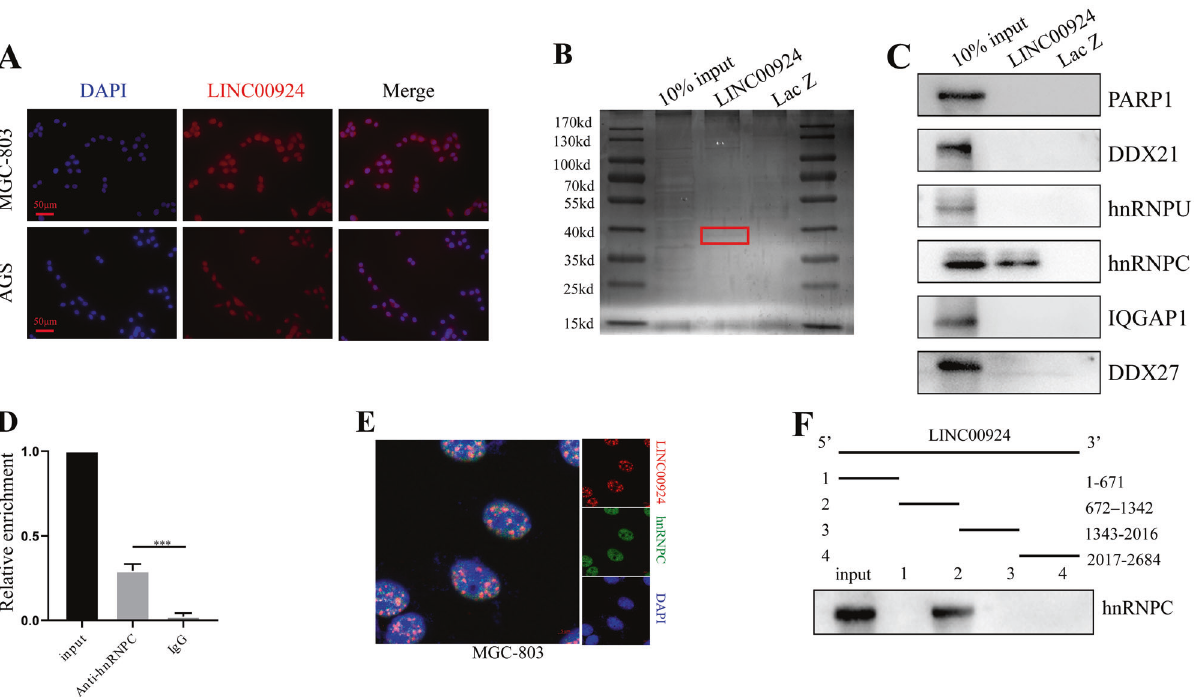
Fig. 4 LINC00924 physically interacts with hnRNPC. A FISH results showing the nuclear localization of LINC00924 (red) in MGC803 and AGS cells. The nuclei were stained with DAPI. B Silver staining of biotinylated LINC00924-interacting proteins. Red boxes indicate speci fi c bands. C WB results used to con fi rm the mass spectrometry results. D RIP analysis conducted using an anti-hnRNPC antibody to validate the interaction between hnRNPC and LINC00924. E Confocal RNA-FISH (red) and immuno fl uorescence (IF) (green) images indicating the colocalization of LINC00924 and hnRNPC. F Results of the LINC00924 serial deletion assay performed to localize the interaction